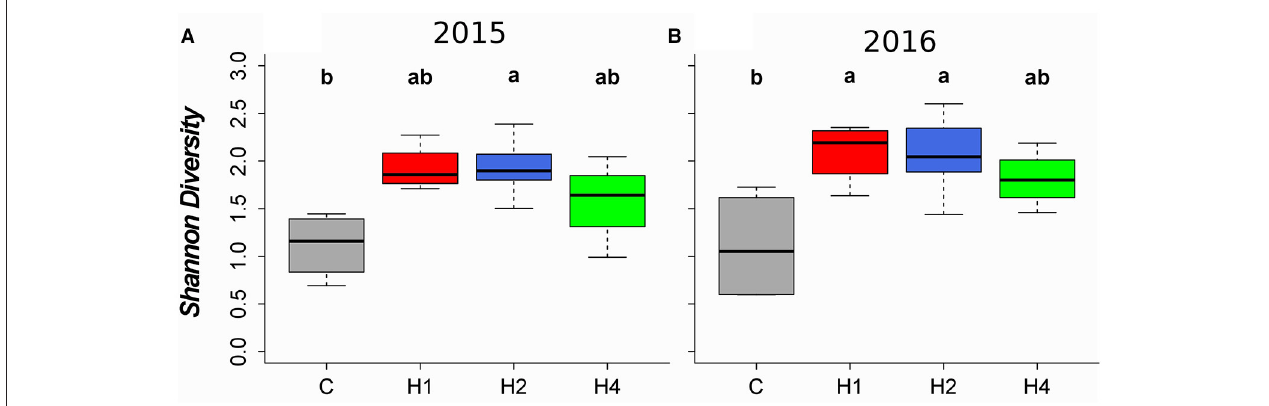
FIGURE 1 | Boxplots of Shannon diversity for the second and third experimental year for the tall herb fringe community. Horizontal lines indicate the median, boxes the interquartile range and whiskers the 95% interval of the data. (A) 2015, (B) 2016. Treatments: C, control; H1, harvest once per year; H2, harvest twice per year; H4, harvest four times per year. Different letters indicate significant difference ( p < 0.05) tested by linear mixed effects model with post-hoc test for pairwise comparisons (for details, see Appendix Table 4 in Supplementary Material). Community-weighted medians (min, max) after the first experimental year (non-significant, LMEM, see Appendix Table 5 in Supplementary Material) as well as boxplots for the other tested community types (non-significant, LMEM) can be found in Appendix Image 2 (Supplementary Material).